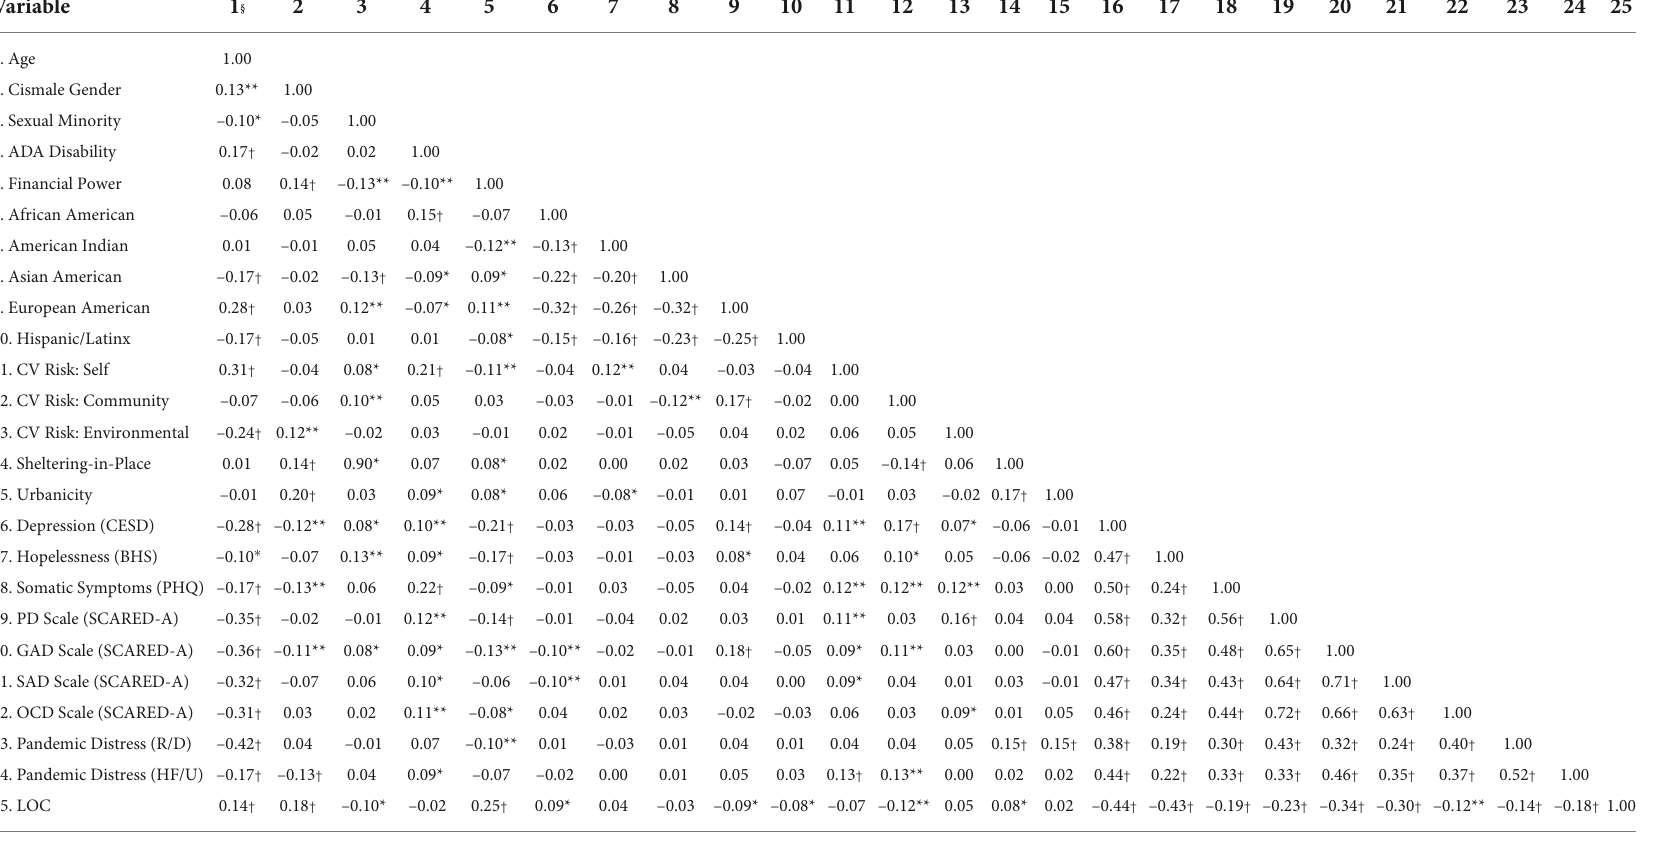
TABLE 2 Partial correlation matrix controlling for